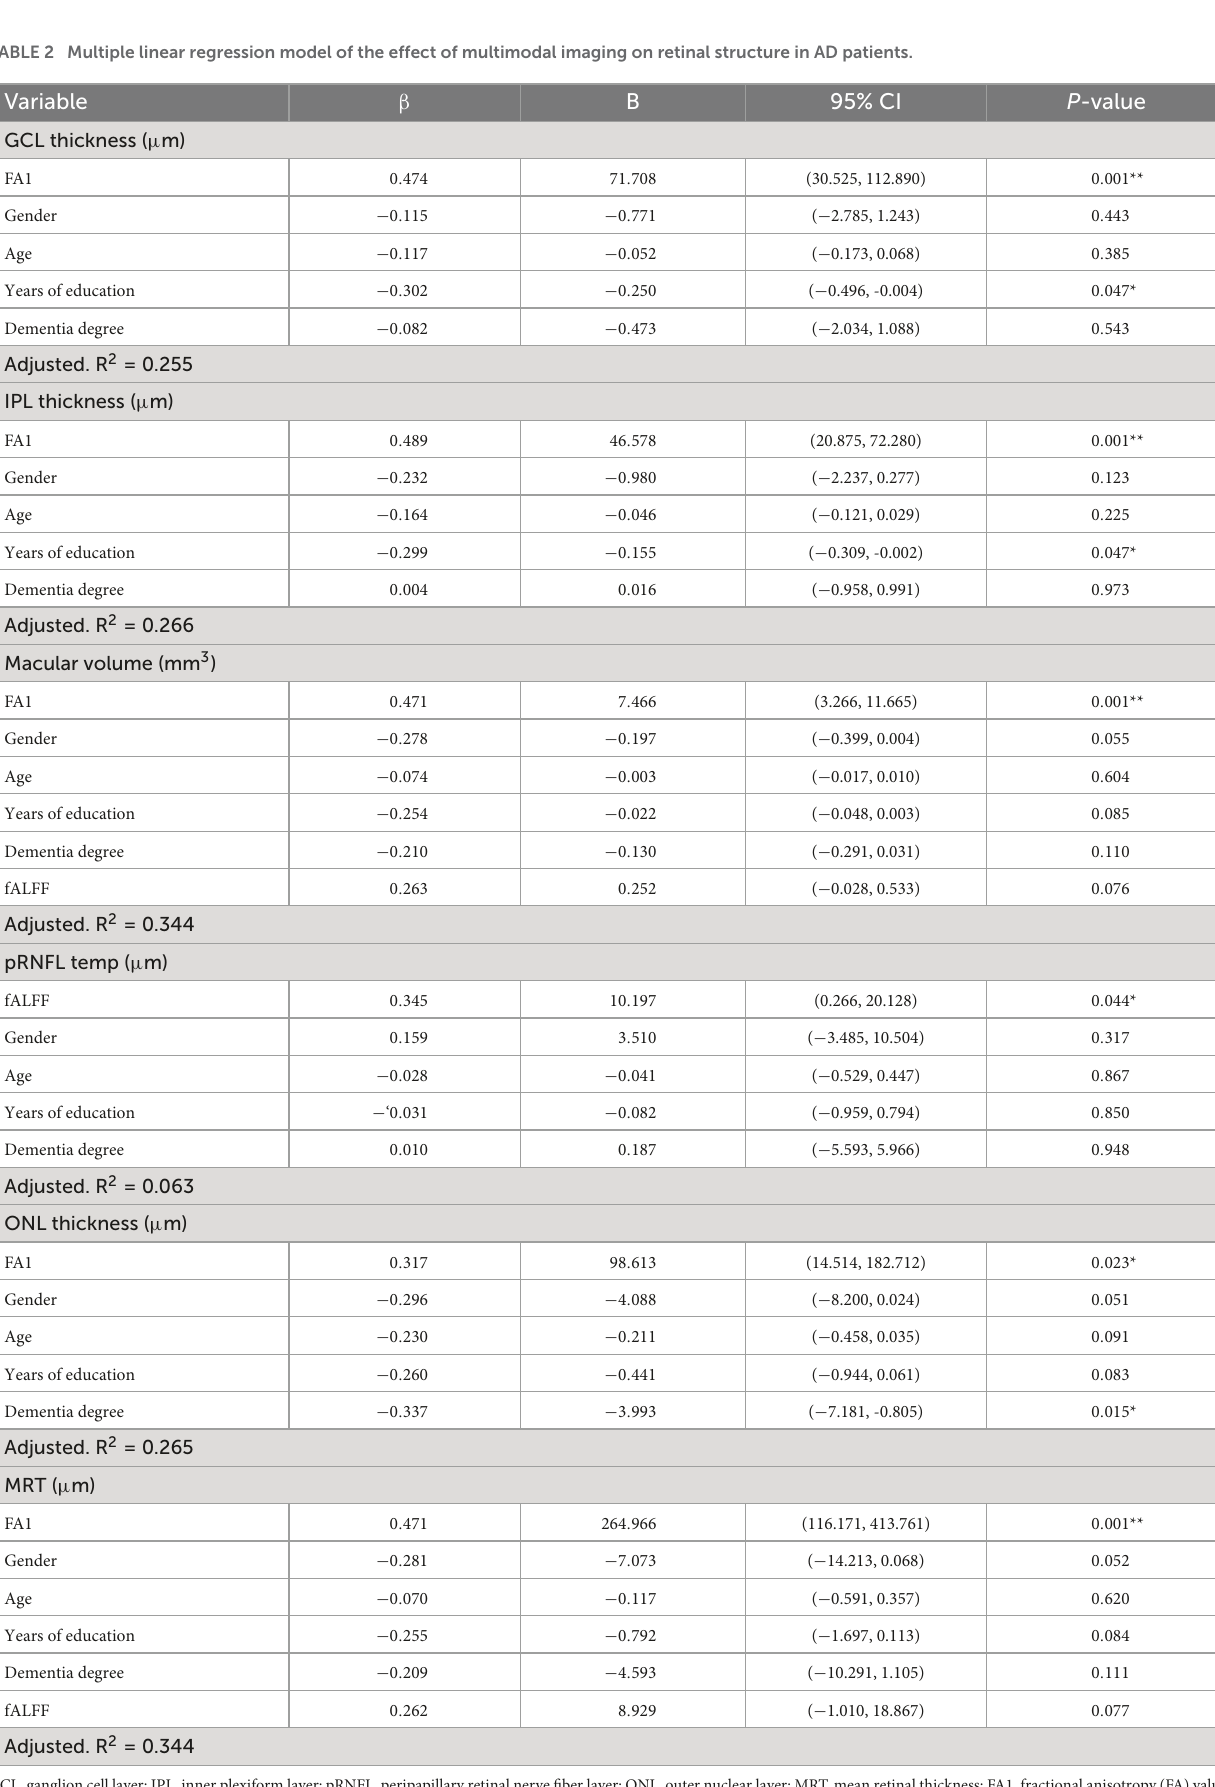
TABLE 2 Multiple linear regression model of the effect of multimodal imaging on retinal structure in AD patients.